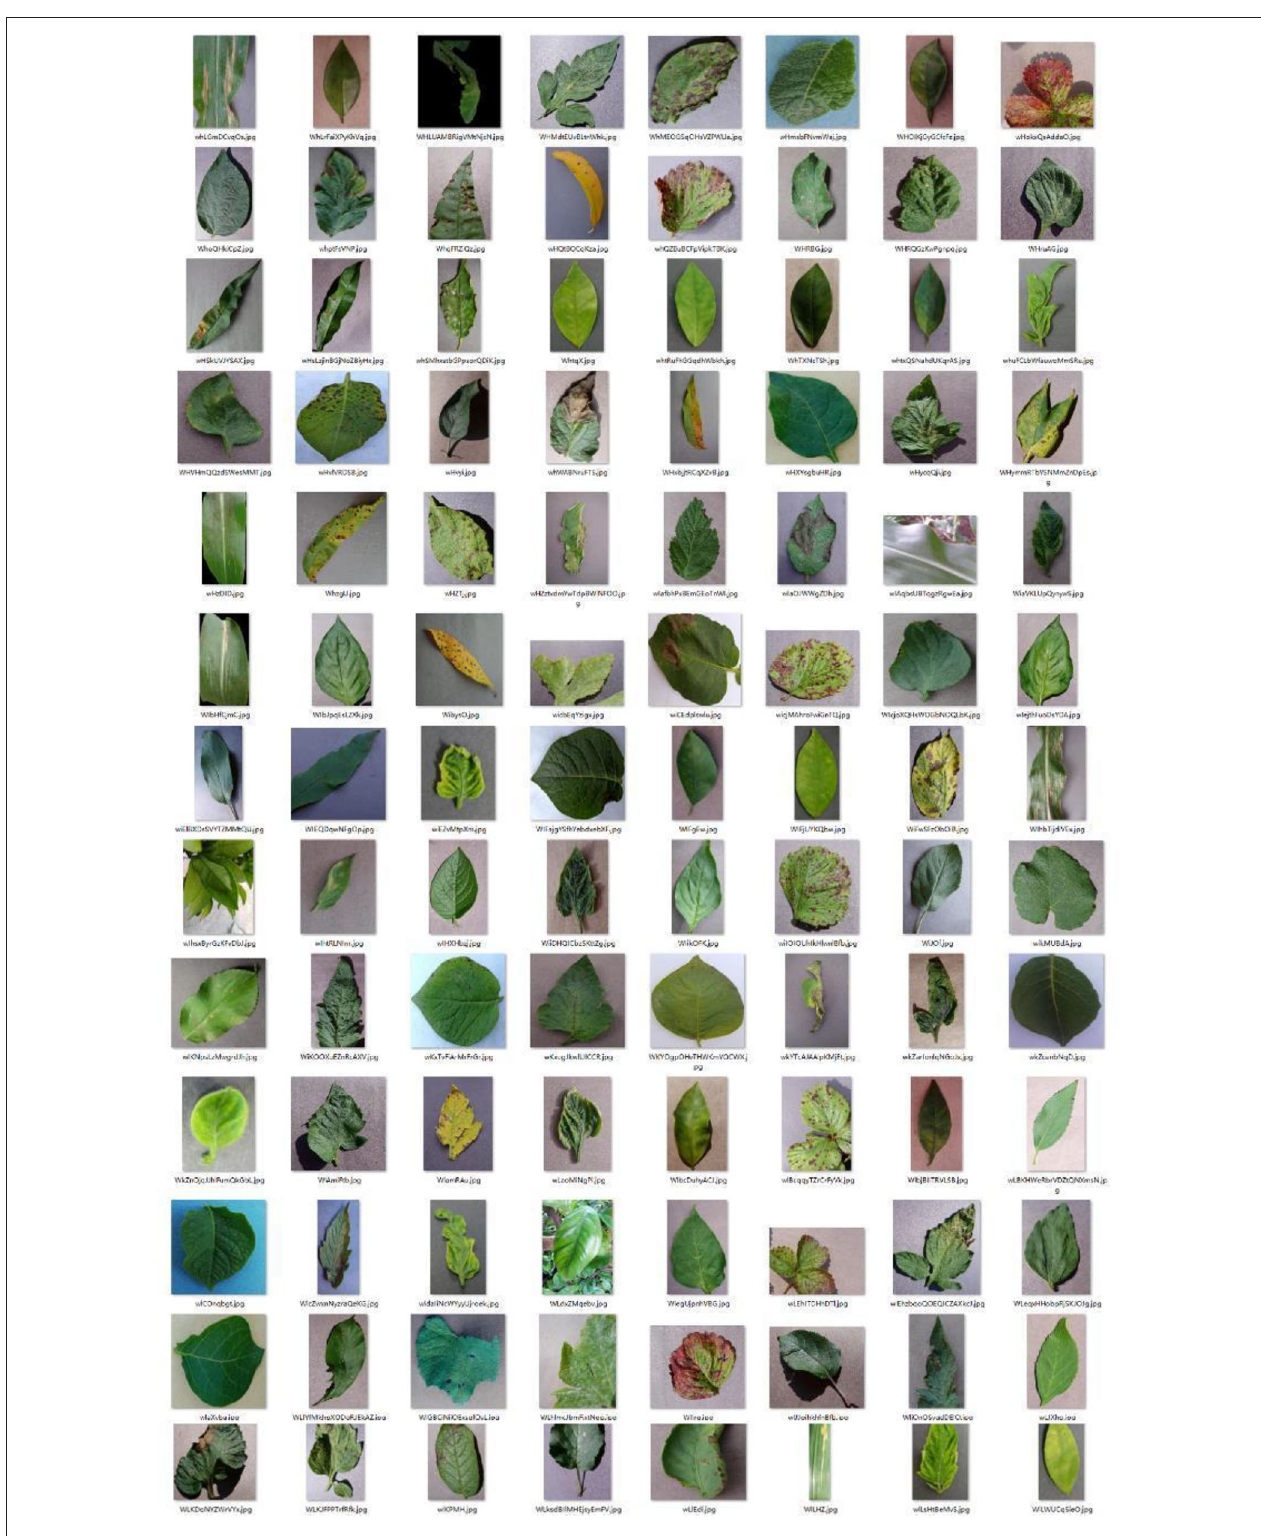
FIGURE 8 | Sample images of the PFD